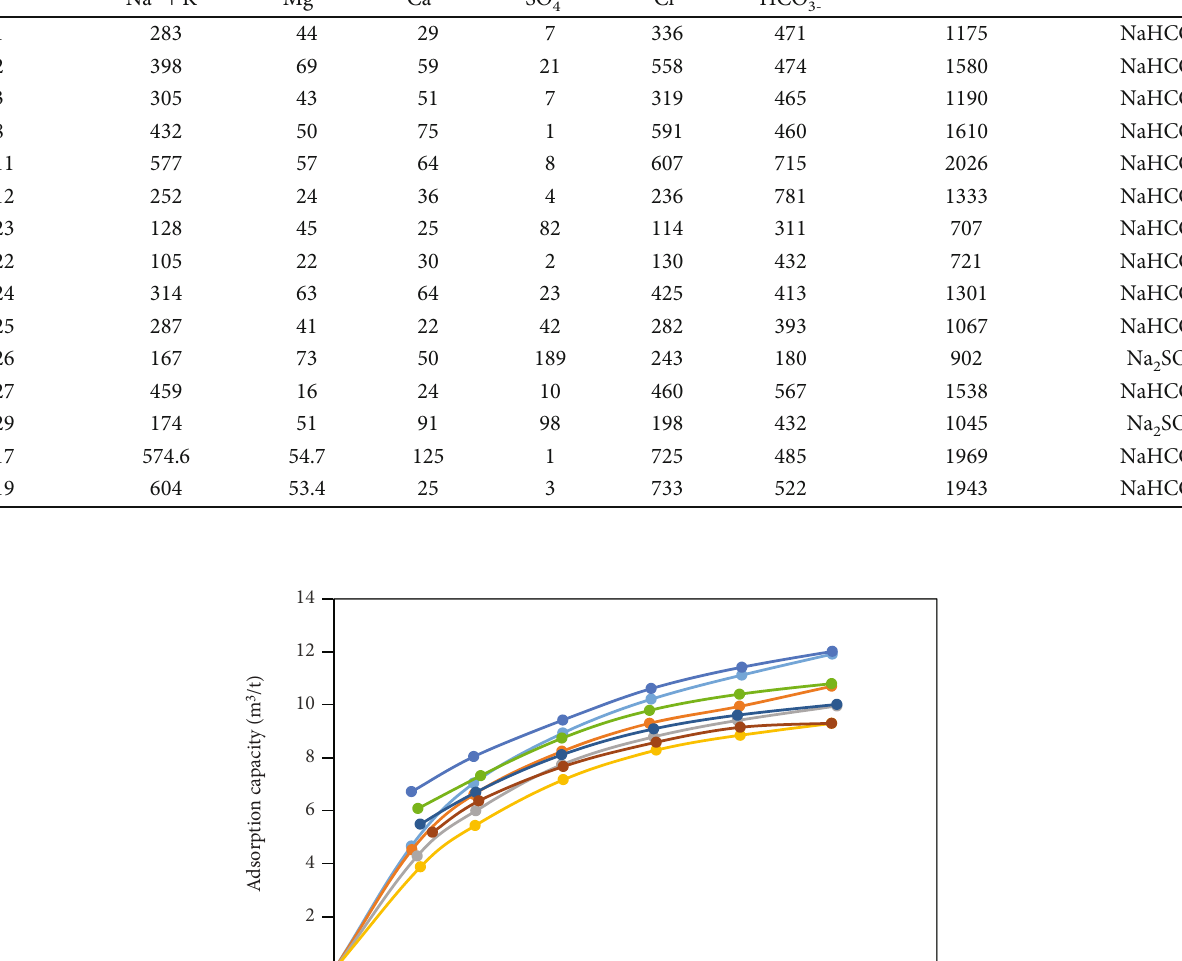
Table 2: The ion composition and water type of produced water in no. 4+5 coal in the Baode block. [17]. Well no.